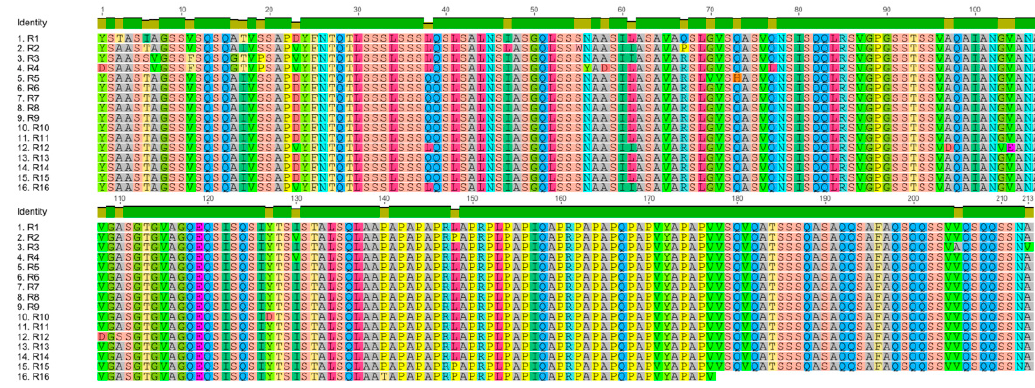
Figure 6. Alignment of the 16 repeat units (R1 through R16) of Araneusventricosus PySp1.